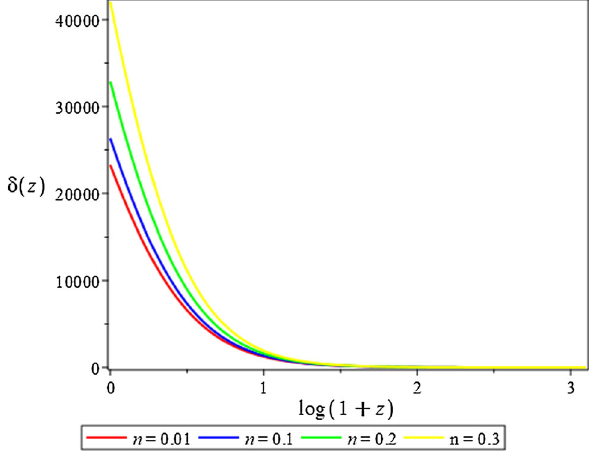
Fig. 18 δ( z ) versus z in long-wavelength mode for Eq. (116) for the n (cid:13)